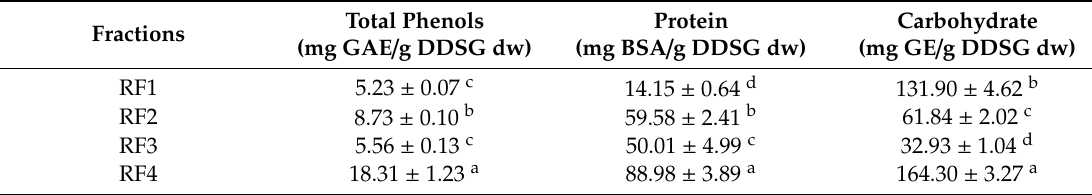
Table 3. Content of total phenols, protein, and carbohydrate in four fractions 1